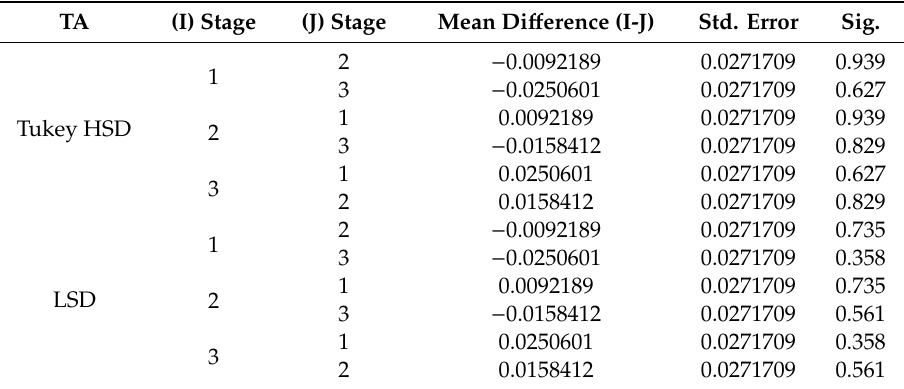
Table 4. Tukey and LSD comparing for property of